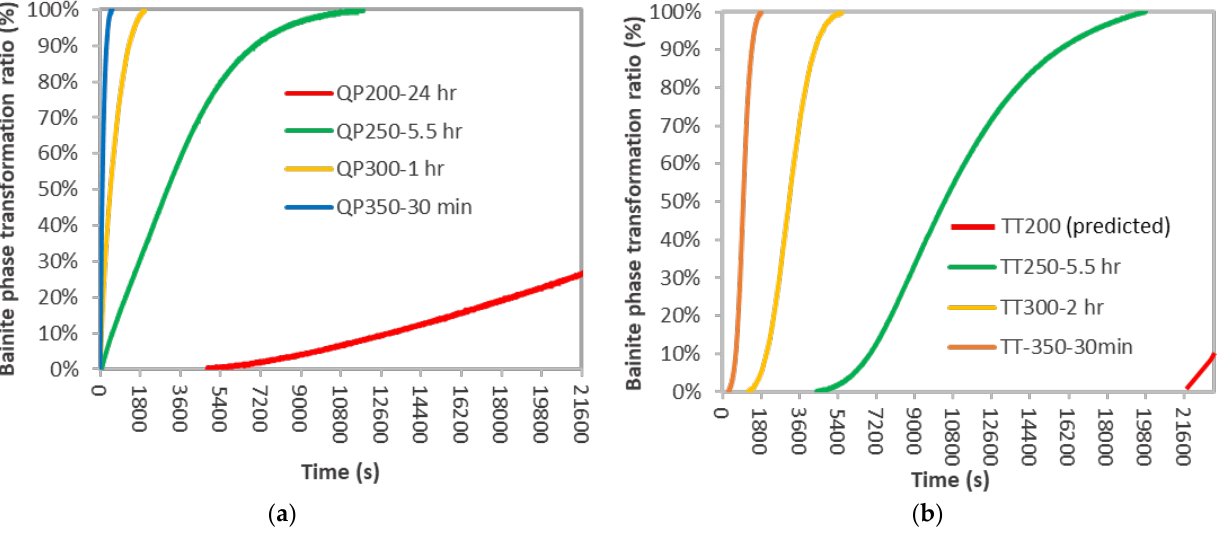
Figure 3. Bainite transformation ratio: ( a ) quenching partitioning; ( b ) isothermal.